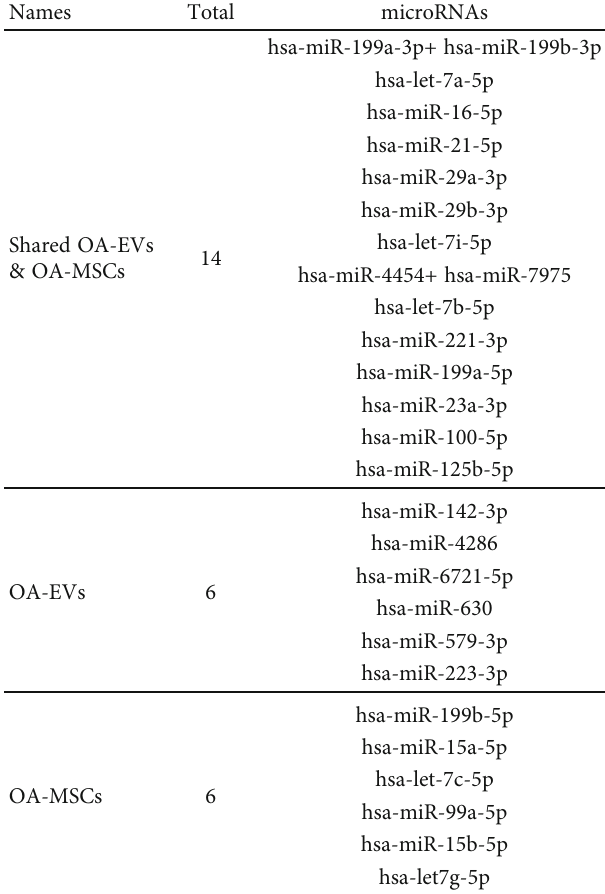
Table 4: microRNAs highly expressed in OA-MSCs and OA-EVs.